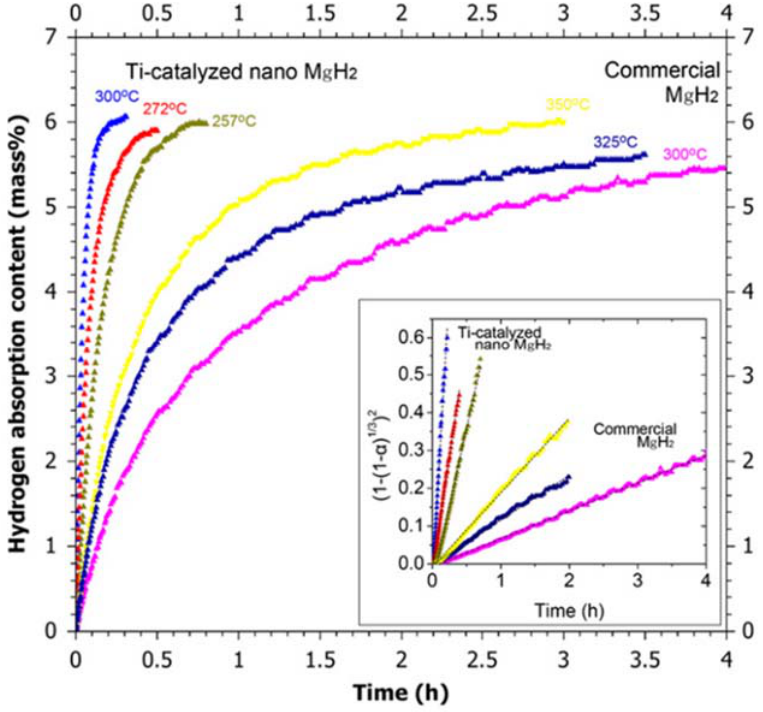
Figure 9. Kinetic performance of Ti ‐ catalyzed and commercial MgH 2 . Reproduced with the permission from [34], Copyright Elsevier, 2012.